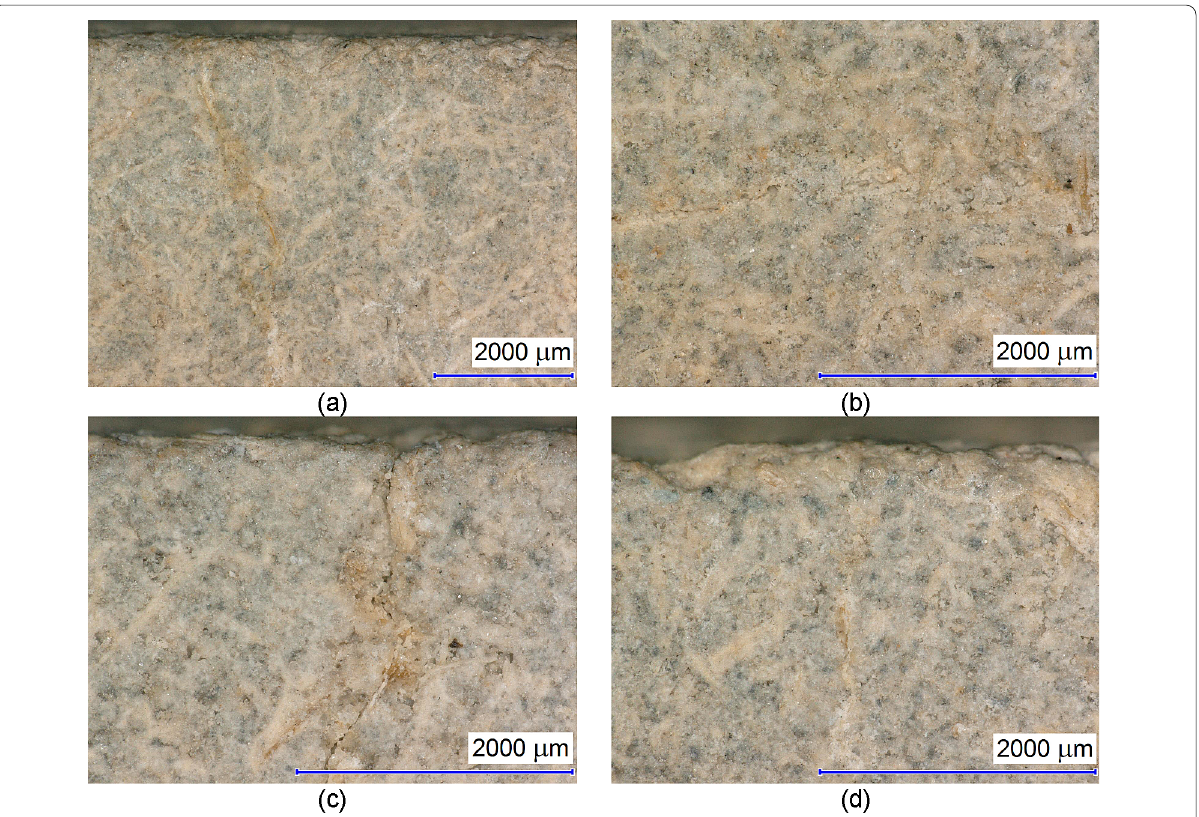
Fig. 21 Structure of boards after 10 th cycle according to EN 321: a REF, b LI10, c SW07 and d